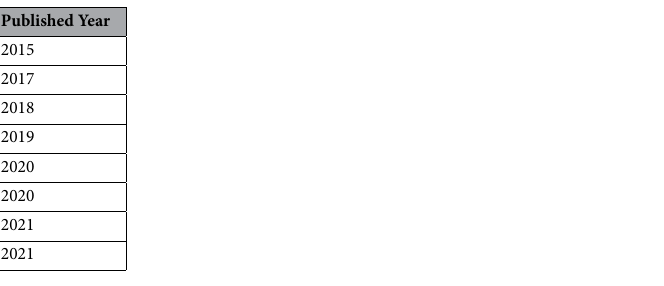
Table 3. List of the polishing tools used in this study.